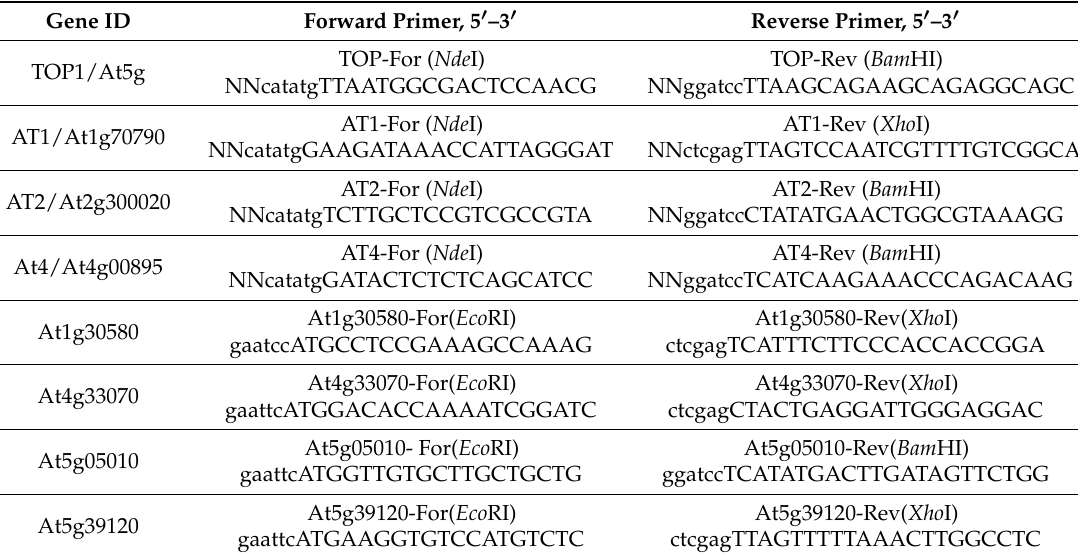
Table 4. Partner proteins of CYP57M selected in the process of Y2H